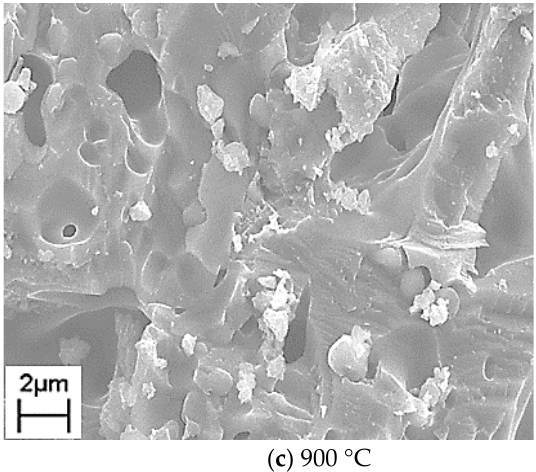
Figure 10. The SEM images of ceramic CaNa samples based on cement-salt stone prepared from powder mixture of calcium citrate tetrahydrate, MCPM, and sodium dihydrogen phosphate, after firing at temperatures of 500 °C ( a ), 700 °C ( b ), and 900 °C ( c ). With an increase in the firing temperature, the grain size increases and the micro- structure of ceramics changed. Spherical grains of 0.5 – 2 µm in size were found in a sample of CaNa ceramic material fired at a temperature of 500 °C. The spherical grains sintered, forming a porous microstructure. The microstructure of the ceramic material CaNa fired at 700 °C was represented by spherical grains with a size in the range 1 – 2 µm. The CaNa sample fired at 900 °C was distinguished by bigger crystals with a size in the range of 1 – 5 µm.